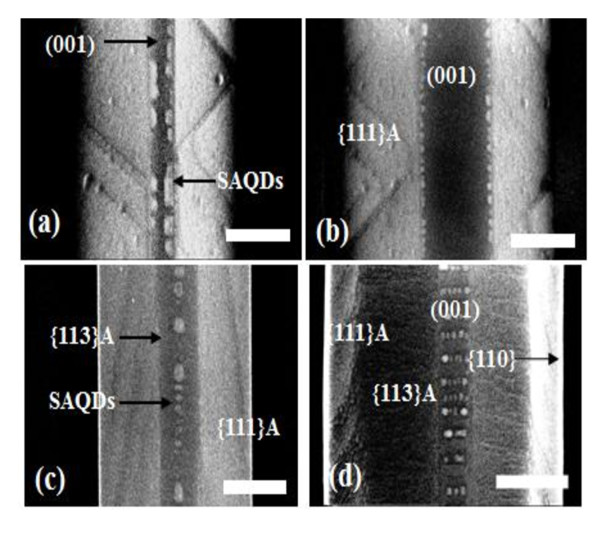
SEM images of In0.8Ga0.2As SAQDs on GaAs buffer layers were formed on SiO2-patterned exact (001) GaAs substrate with W0 of (a) 275 and (b) 630 nm, respectively. SEM images of In0.8Ga0.2As SAQDs on GaAs buffer layers were formed on SiO2-patterned 5°-off (001) with W0 of (c) 285 and (d) 730 nm, respectively.